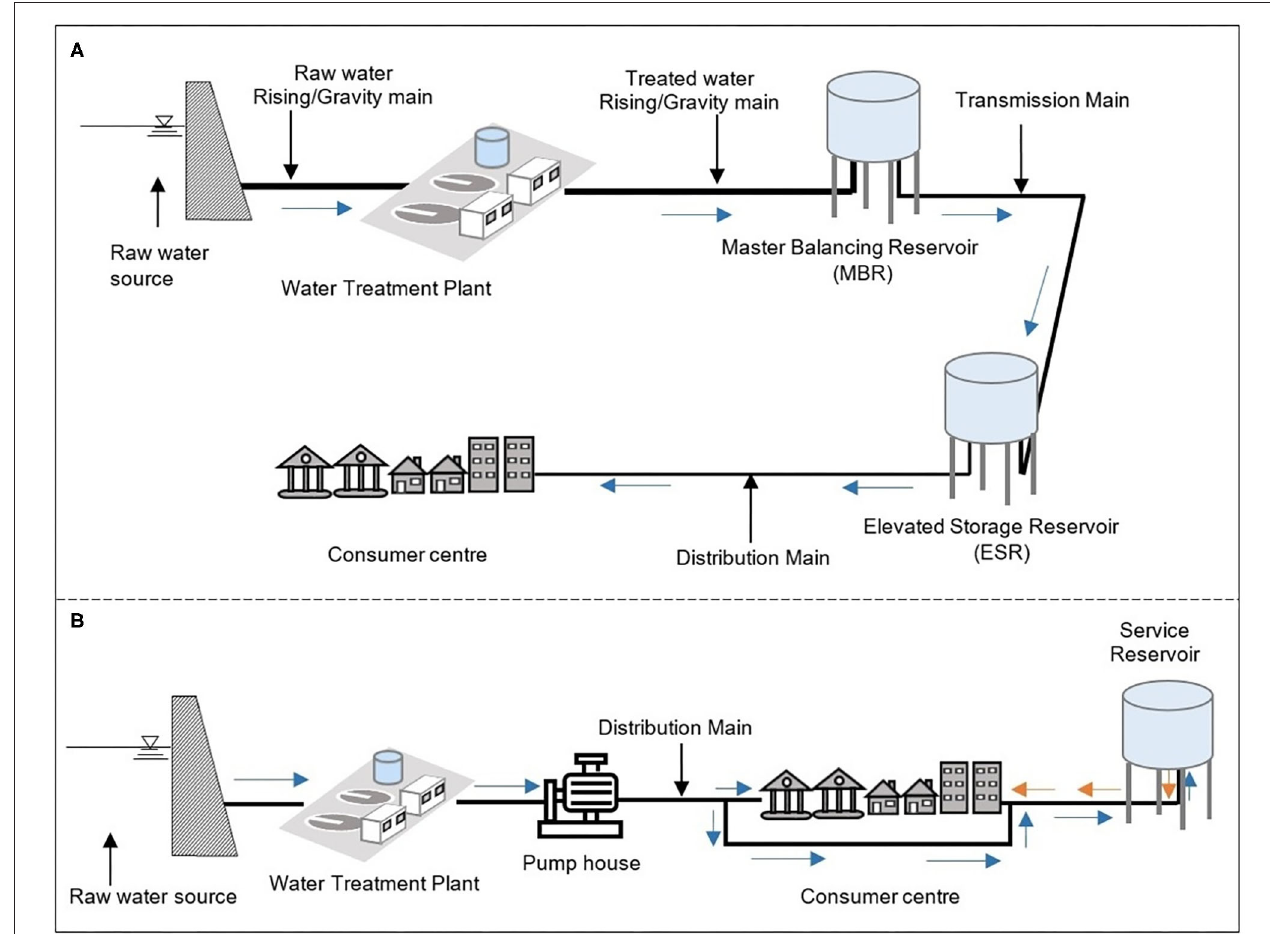
FIGURE 2 | (A) Typical layout of WSS with a surface water source in India, (B) Recommended WSS layout by AWWA manual M31.